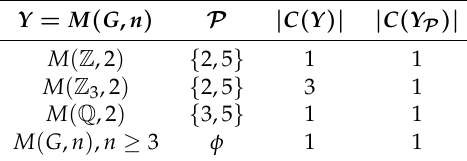
Table 3. The finite case: Moore